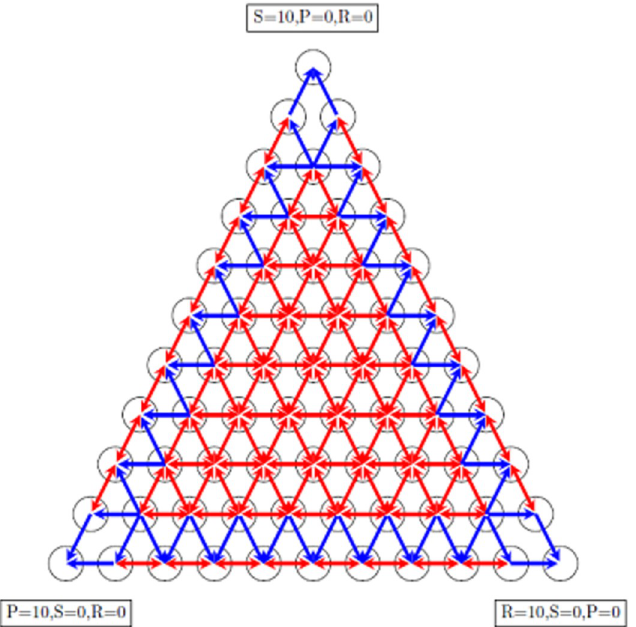
Fig 1. The absorbing Markov chain corresponds to an evolutionary RSP game with a population N = 10. The total number of states is 55, and the arrows determine the allowed transitions between states. Some arrows are two-way, and some of them are one-way arrows. Inside the simplex, all the states are transient, and transitions between them are two ways. Transitions between the inside of simplex and sides are one way. It means when the Markov chain is in the states of sides, it never goes back inside the simplex. In other words, when a strategy extinct, it never appears in population anymore. Transitions between states of sides are two-way too, except transitions between absorption states and their neighbors, which is one